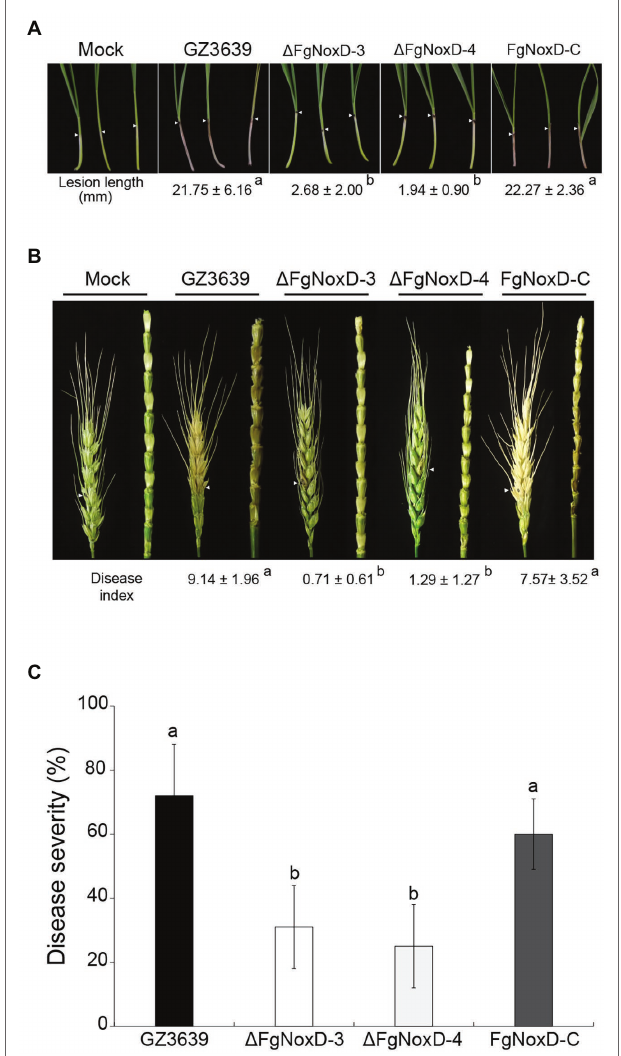
FIGURE 7 | Virulence of GZ3639, Δ FgNoxD, and FgNoxD-C. (A) Wheat coleoptiles were inoculated with 2 μ l conidial suspension (1 × 10 6 conidia/ml in 0.01% Tween-20), and lesion length was measured for at least 10 wheat coleoptiles at 10 dpi. This experiment was repeated three times. (B) Flowering wheat heads were inoculated with 10 μ l conidial suspension (1 × 10 6 conidia/ ml in 0.01% Tween-20) and observed at 14 dpi. Disease index was determined from the number of symptomatic spikelets per wheat head. At least 14 wheat heads inoculated with F. graminearum strain were examined in addition to the wheat head rachis. (C) Flowering rice heads were dipped into conidial suspension (1 × 10 5 conidia/ml in 0.01% Tween-20) for 30 s and symptomatic rice grains per rice head were examined at 14 dpi. Disease severity was determined from the number of symptomatic grains per rice head. This experiment was repeated three times. Values with different letters are significantly different according to Tukey’s test ( p <